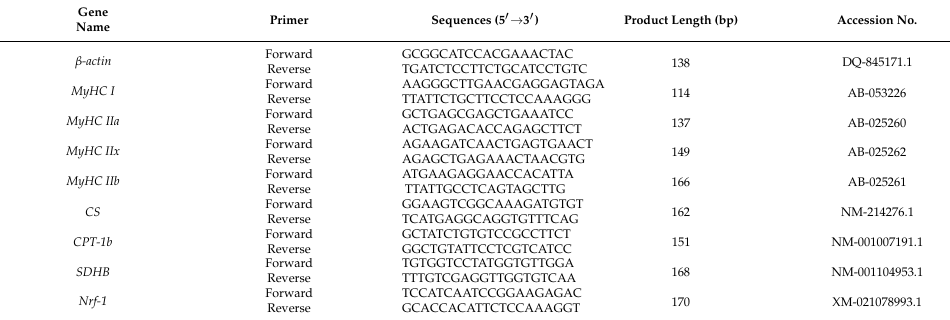
Table 2. The primer sequences used for real-time quantitative